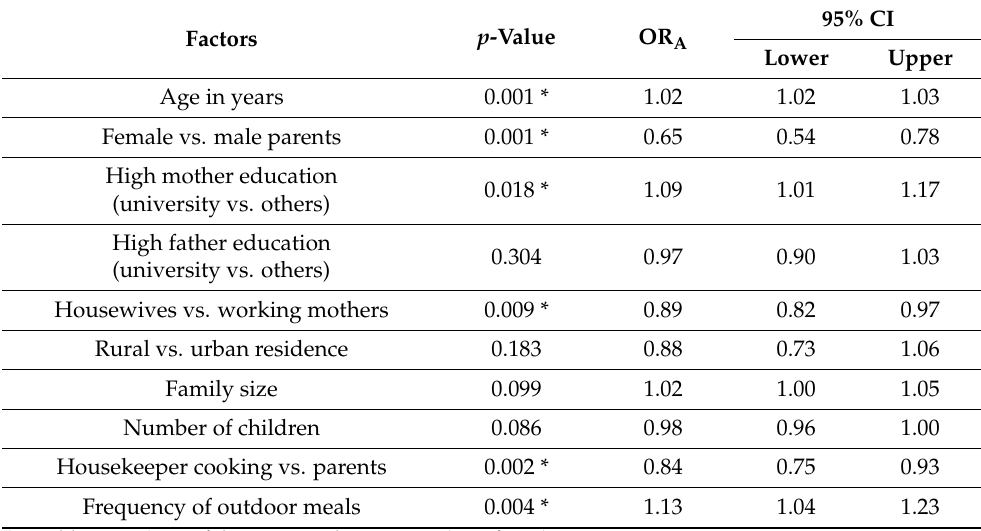
Table 6. Multiple logistic regression model for determinants of parents’ knowledge regarding food